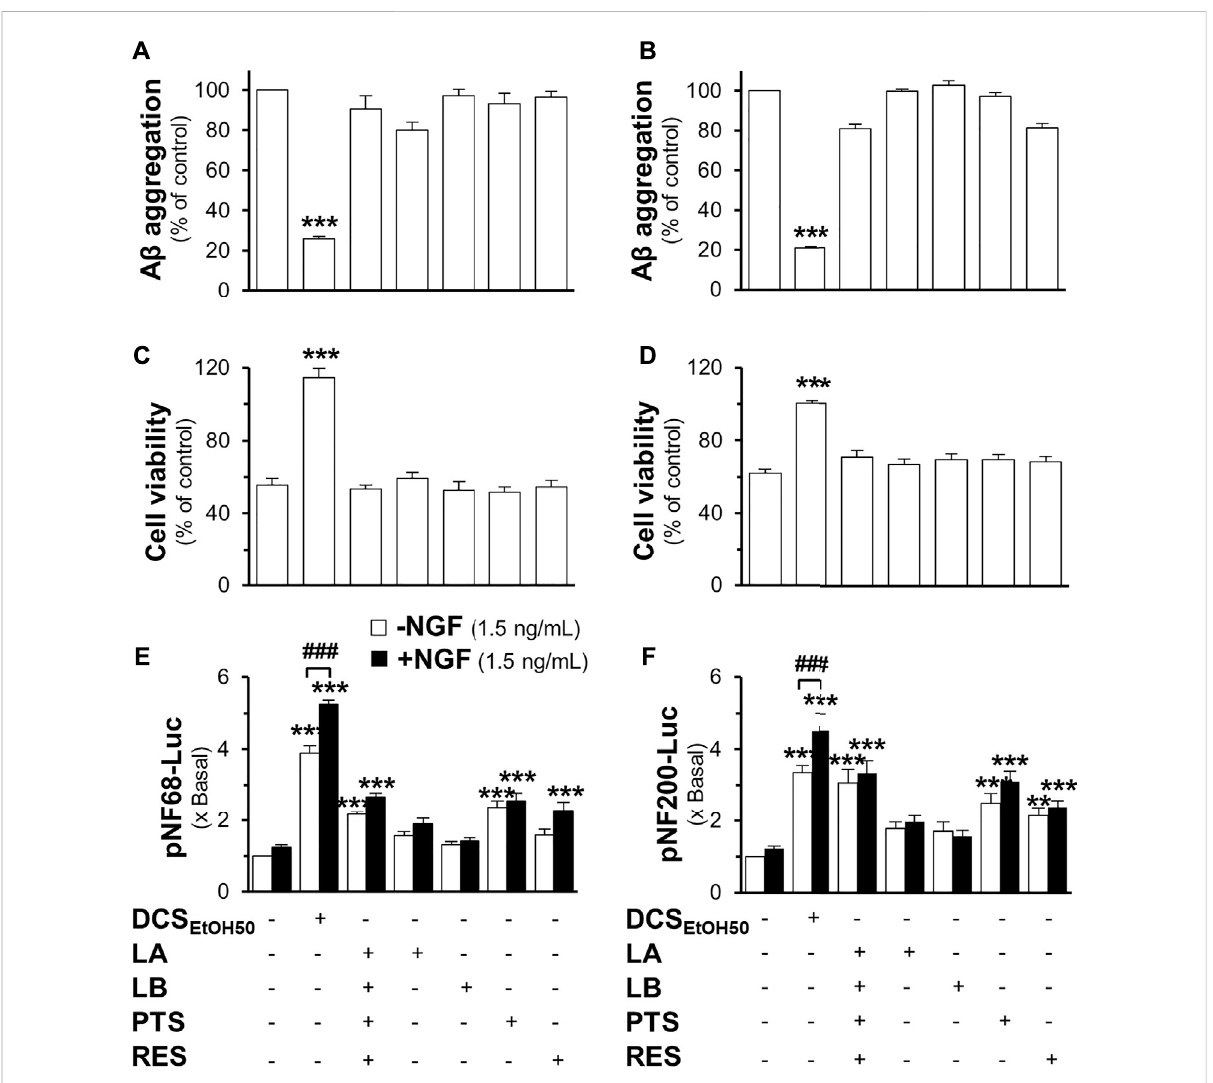
FIGURE 10 The mixture of major compounds does not account for the activity of the D. cochinchinensis stemwood extract. The activity of loureirin A (LA; 0.8 μ M), loureirin B (LB; 0.7 μ M), pterostilbene (PTS; 1.1 μ M), or resveratrol (RES; 1.2 μ M), with 20 μ g/ml DCS EtOH50 as well as DCS EtOH50 (20 μ g/ml), wasanalyzed. (A) InhibitionofA β 1-42 fi brilization:A β 1-42 monomers(10 μ M)wereincubatedwiththesecompoundsandDCS EtOH50 for 6 days (B) The reversalofA β aggregates:A β fi brils(10 μ M;aged6 days)weretreatedwiththecompoundsorherbalextractsfor5 days,andA β aggregationwas measured using ThT fl uorescence. (C) Cells were treated with 6-days co-aggregated A β 1-42 monomers (10 μ M) and the compounds or extracts for 24 h. (D) Cells were pre-treated with the compounds or extracts for 24 h before exposure to A β fi brils (10 μ M). Cell viability was measured by using theMTTassay. (E) CellsweretransfectedwithpNF68-Lucor (F) pNF200-Lucbeforetreatmentwiththecompoundsortheextractinthepresenceor absence of 1.5 ng/ml NGF for 24 h, and then subjected to the luciferase analysis. Data are presented as mean ± SEM for n ≥ 4. ** p < 0.01 and *** p